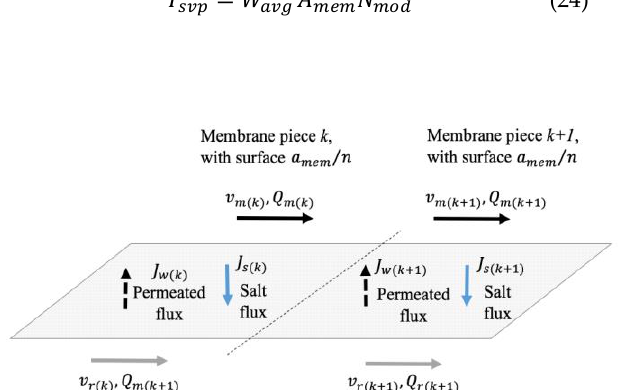
Fig. 3. Spatial variations in flow rates, concentrations and hydraulic pressures along the